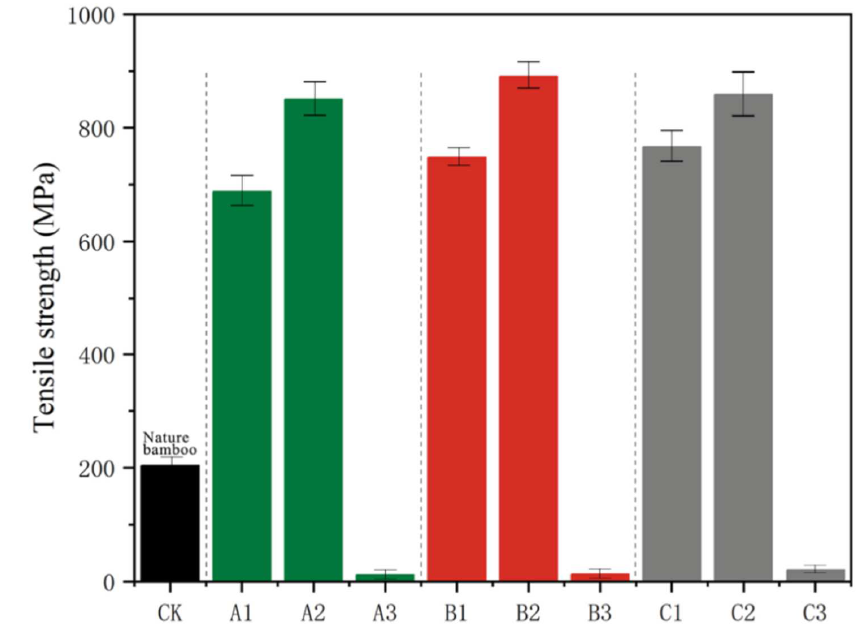
Figure 4. Tensile strength of natural bamboo fibers (CK) and bamboo fibers treated with different delignification processes.